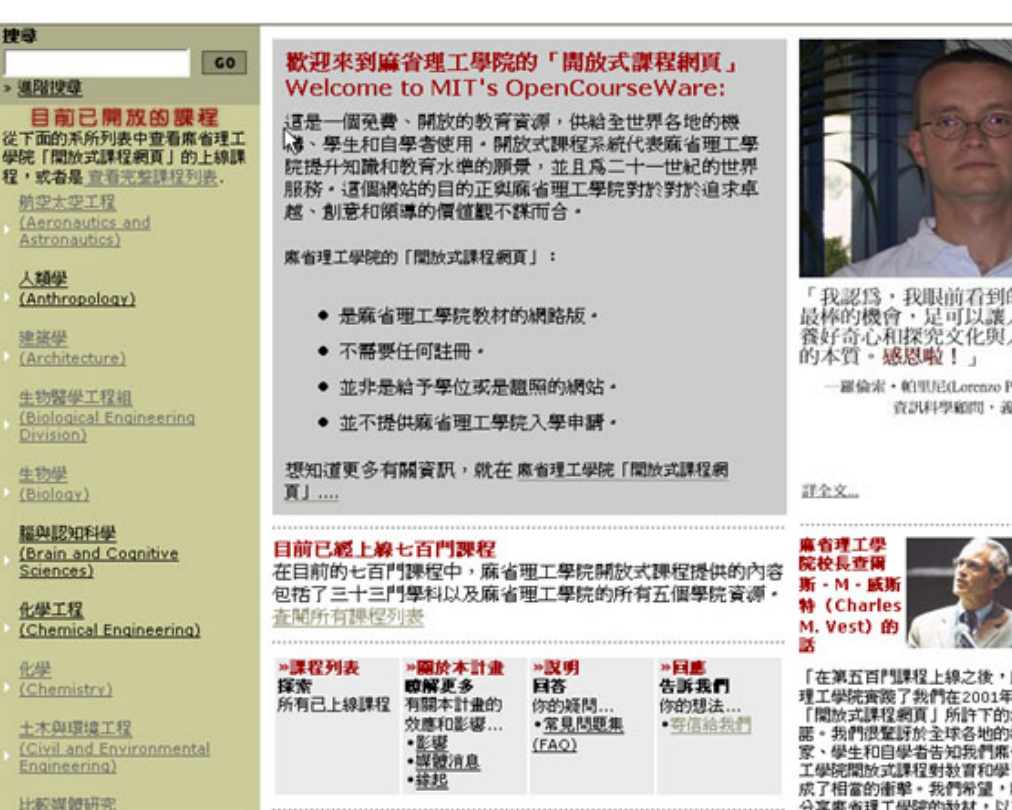
Figure 2. MIT OCW mirror site in